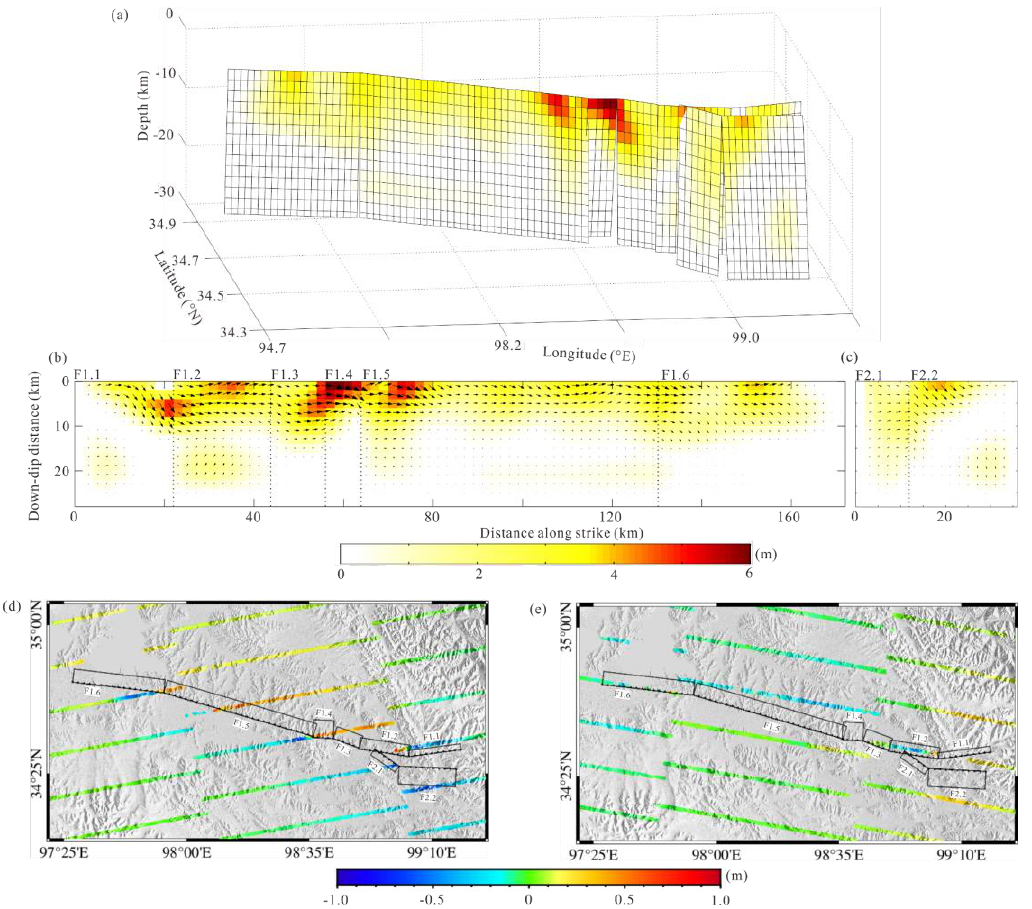
Figure 10. Fault slip model of the 2021 Maduo earthquake constrained by DInSAR and BOI observations: ( a ) F1 and F2 faulting model with three-dimensional view; slip distribution on F1 ( b ) and F2 ( c ) with planar view; inferred fault models projected onto the ascending ( d ) and descending ( e ) azimuth displacement fields derived from the BOI technique. Black rectangles indicate the surface projection of the constructed faults.